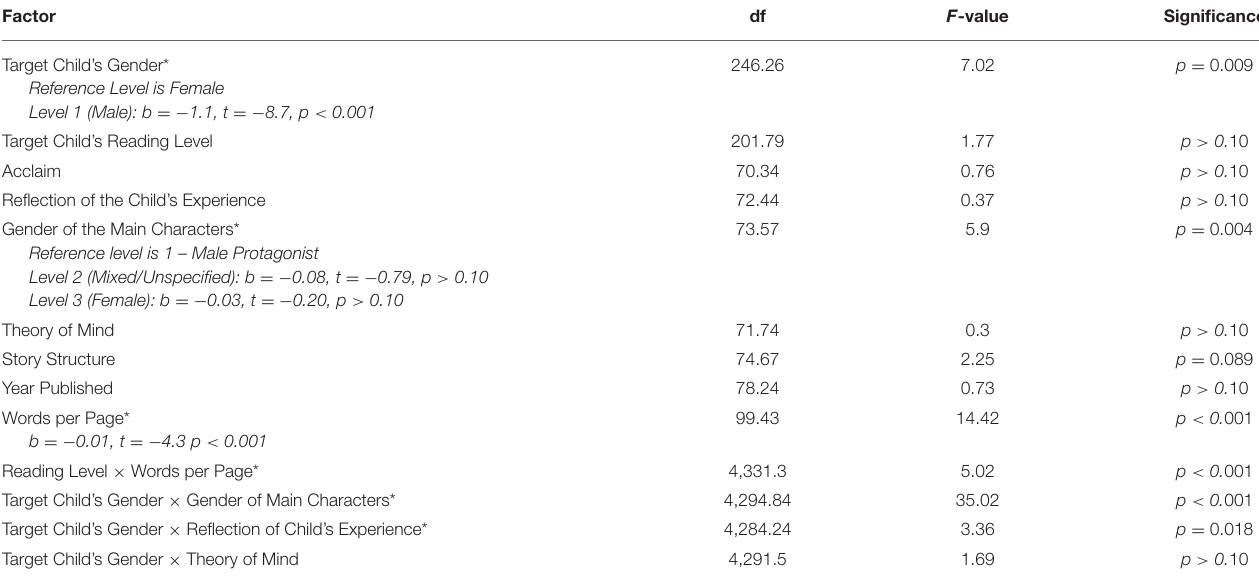
TABLE 5 | Results for children’s perceived preferences. Factor df F -value Significance Target Child’s Gender* Reference Level is